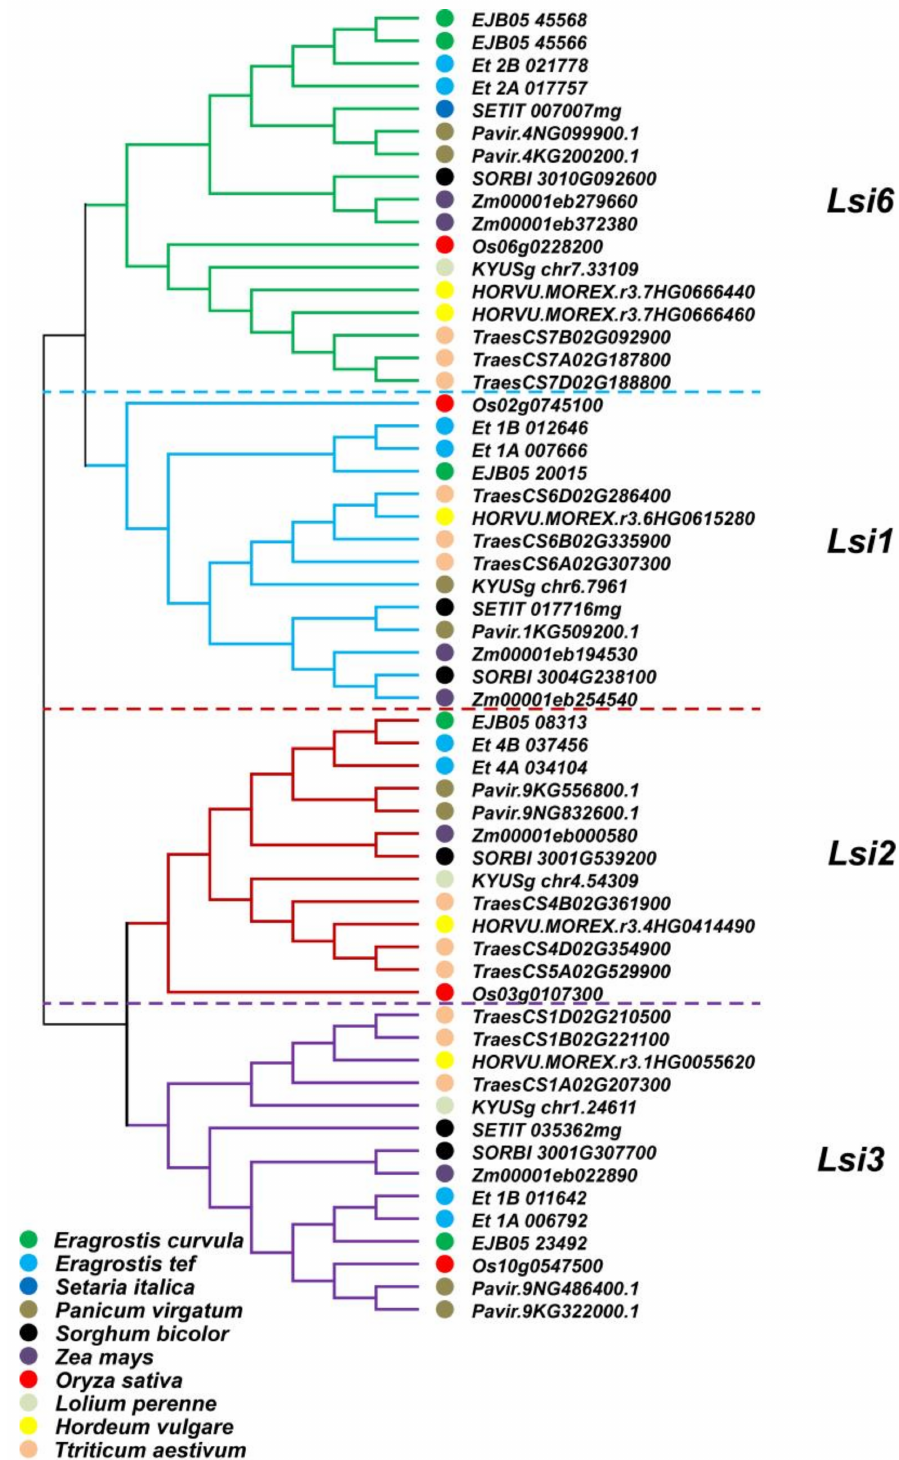
Figure 3. Neighbor-joining phylogenetic tree using Lsi1 , Lsi2 , Lsi3 , and Lsi6 genes of ten species of grasses: Eragrostis curvula , Eragrostis tef , Setaria italica , Panicum virgatum , Sorghum bicolor , Zea mays , Oryza sativa , Lolium perenne , Hordeum vulgare , and Triticum aestivum . Each species is represented by a different